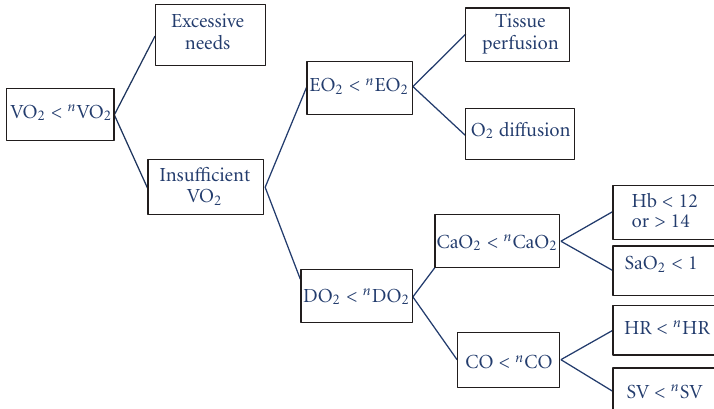
Figure 1: Root algorithm for representing the global hemodynamic model. The model gives priority to the higher box as compared to the lower. For example at the first step, the algorithm recommend decreasing excessive needs before looking at improving VO 2 .